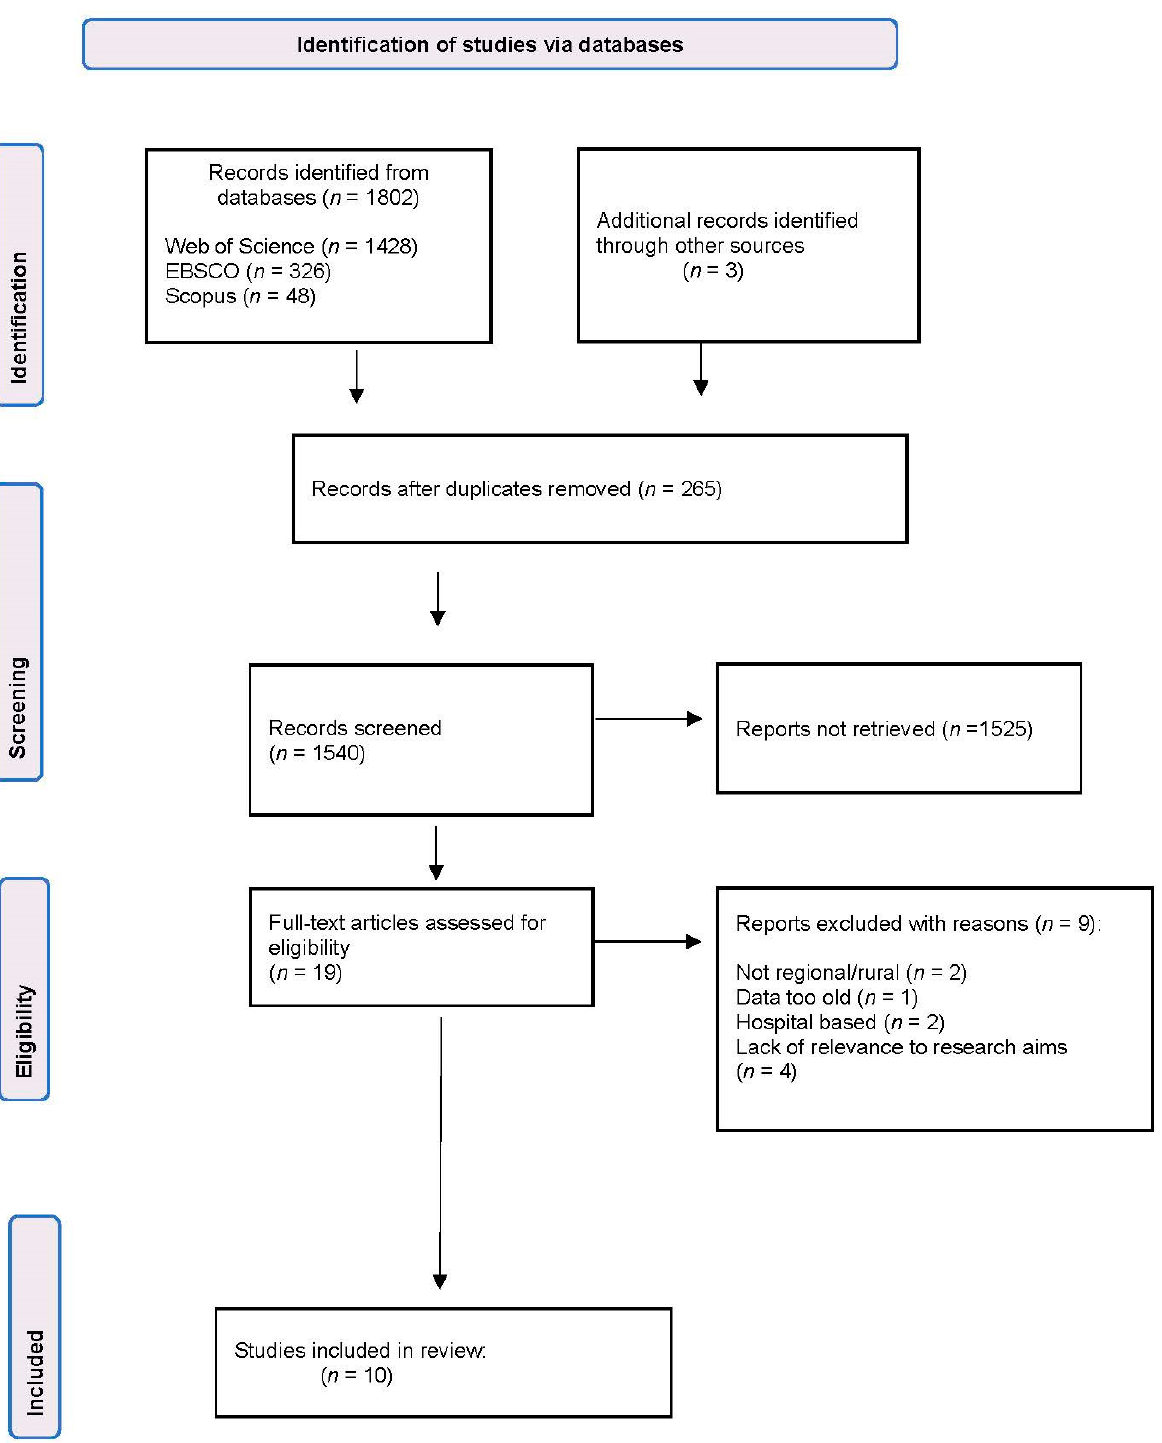
Figure 1. Modified PRISMA flowchart of the search strategy [15].